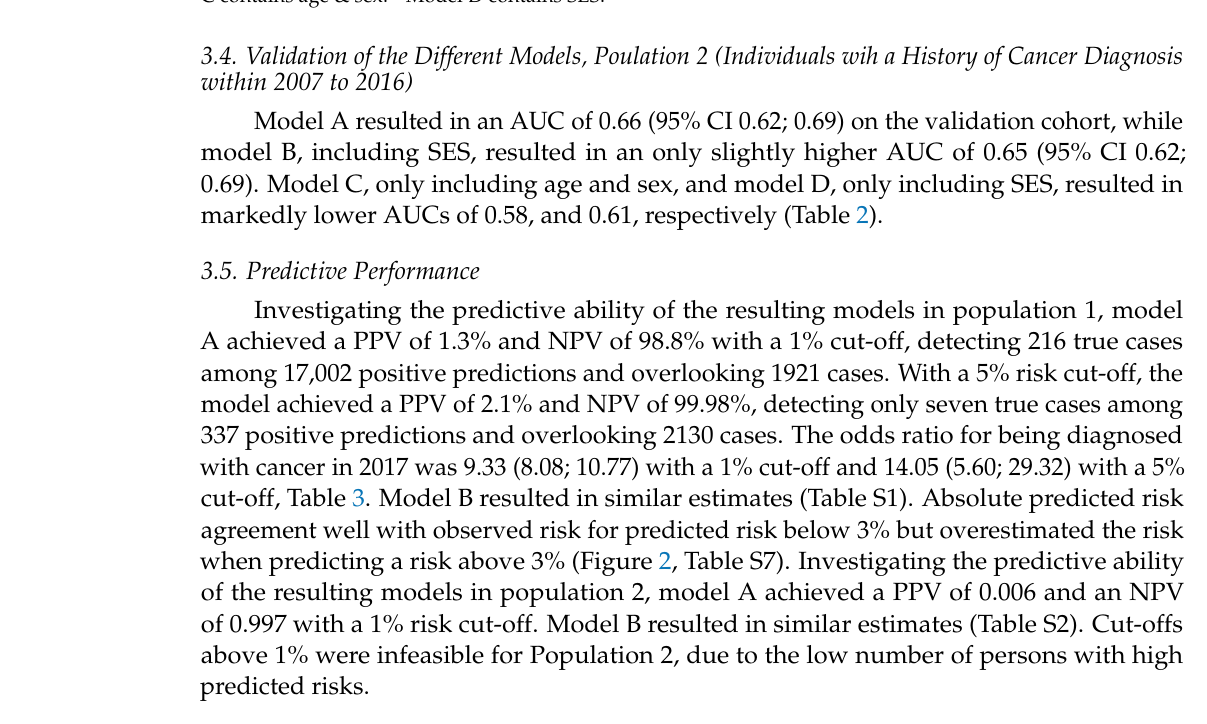
Table 3. Absolute predictive performance of Model